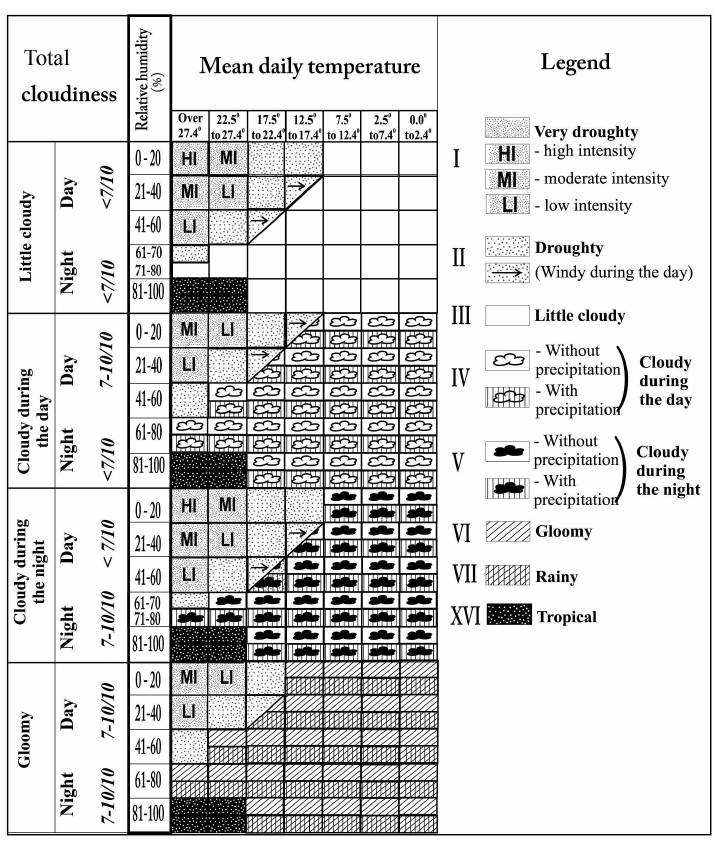
Figure 1. Weather classes during the warm part of the year (source: Tishkov, 1985).